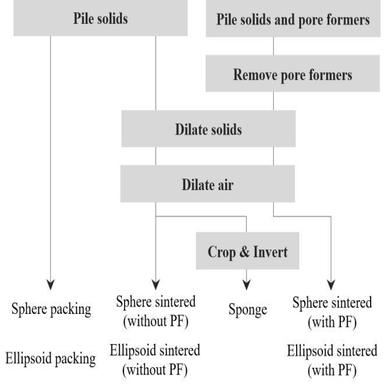
Preparation procedures of the artificial porous structures.